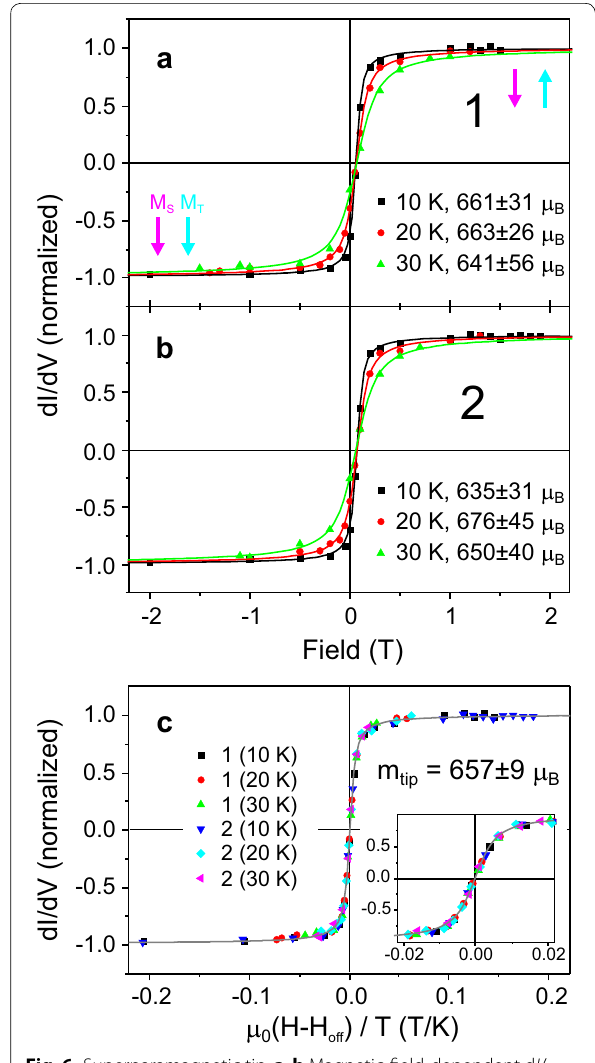
Fig. 6 Superparamagnetic tip. a , b Magnetic‑field‑dependent d I / d V plots in a and b extracted from the hysteresis loops of Fig. 2c, d respectively. The d I /d V curves at each temperature are normalized by fits using Eq. 8, as shown by the solid curves . The legend gives the measurement temperature and the total magnetic moment in μ B , as extracted from the fit of the data with the Eq. 8. c , Plots of all d I /d V values as a function of reduced magnetic field (μ 0 H / T ). The inset is a close‑up of the plots around μ 0 ( H – H off )/ T 0. The gray curve shows = the Langevin fit in one curve for all data (Reprinted from [19] with permission from American Institute of Physics (Copyright